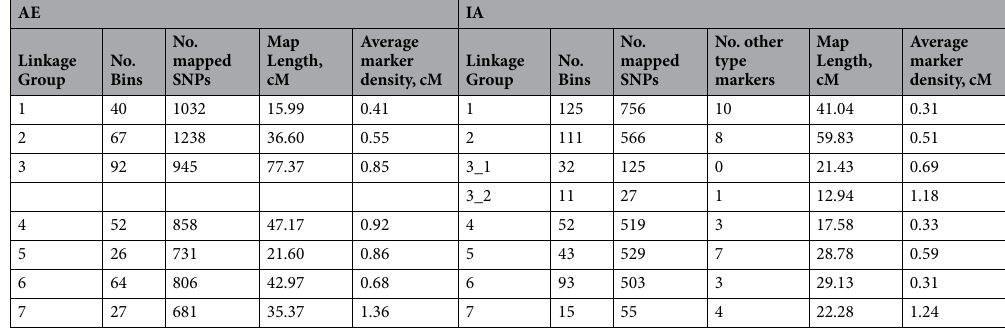
Table 1. Summary of the linkage maps for the P . axillaris × P . exserta (AE) RIL population and the P . integrifolia × P . axillaris (IA) RIL populations.